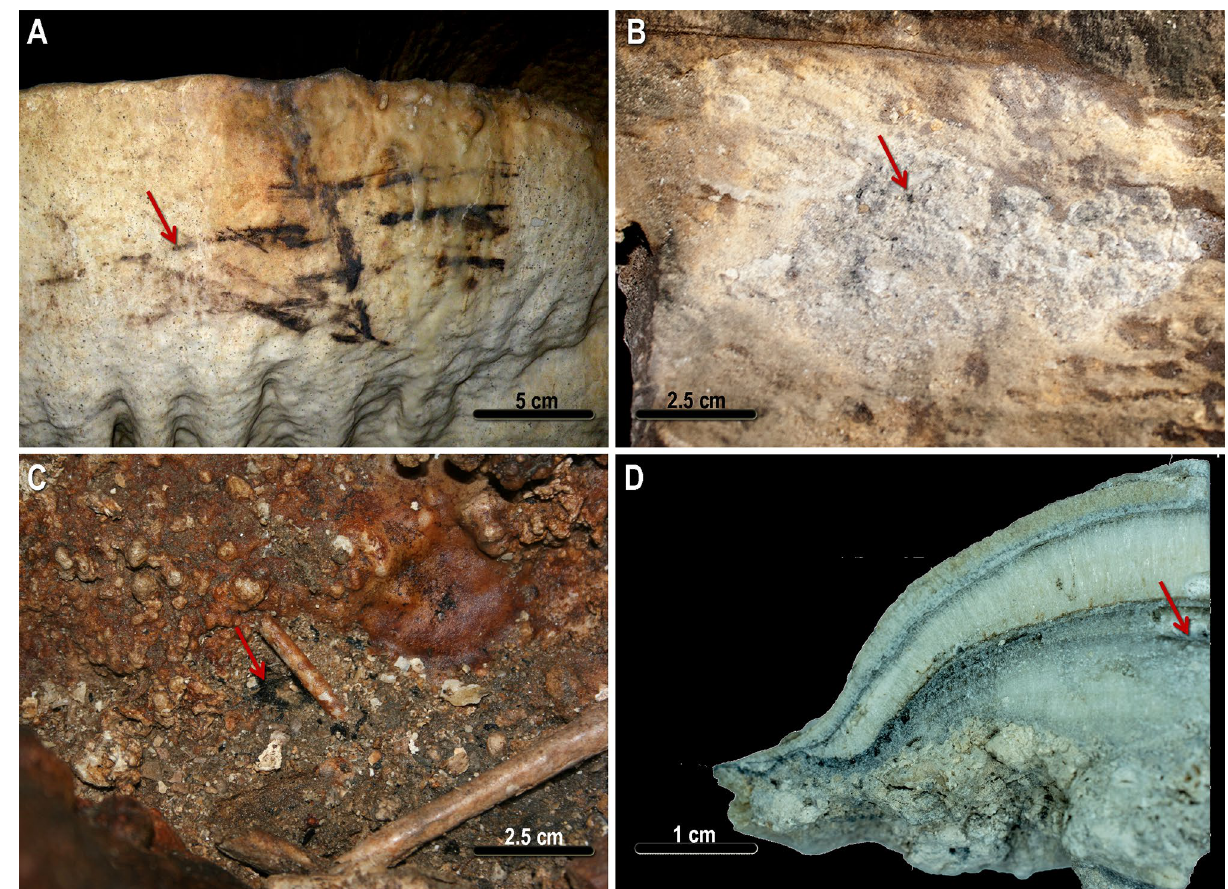
Figure 1. Image composition of the materials. ( A ) Black mark (dating number 33). ( B ) Micro-charcoal inside fixed lamp (dating number 43). ( C ) Scattered charcoals (dating number 54). ( D ) GN16-08 stalagmite section. The red arrows point to one of the samples, analysed both by TEM–EDX and Raman